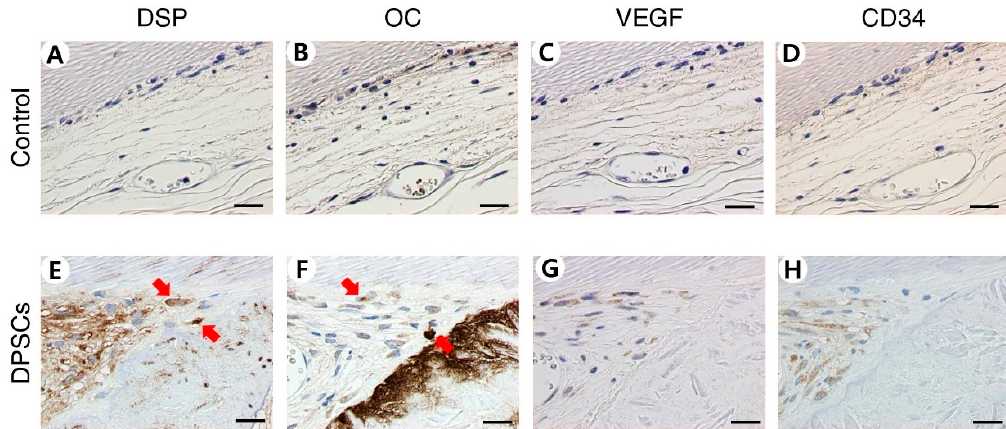
Figure 5. Immunohistochemical staining of dHDP transplants recellularized with DPSCs. dHDP transplants immunostained with ( A , E ), anti-human DSP, ( B , F ) anti-human OC, ( C , G ) anti-human VEGF, and ( D , H ) anti-human CD34 antibodies. Red arrows indicate positively immunostained cells. Scale bars: 20 μ m. Abbreviations: dHDP, decellularized human dental pulp; DPSCs, dental pulp stem cells; DSP, dentin sialoprotein; OC, osteocalcin; VEGF, vascular endothelial growth factor; CD34, cluster of differentiation 34.